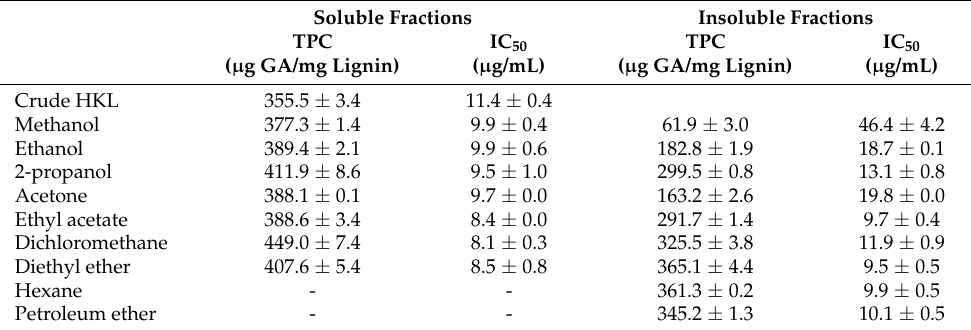
Table 4. Total phenolic content (TPC) and efficient concentration (IC 50 ) of fractionated lignin